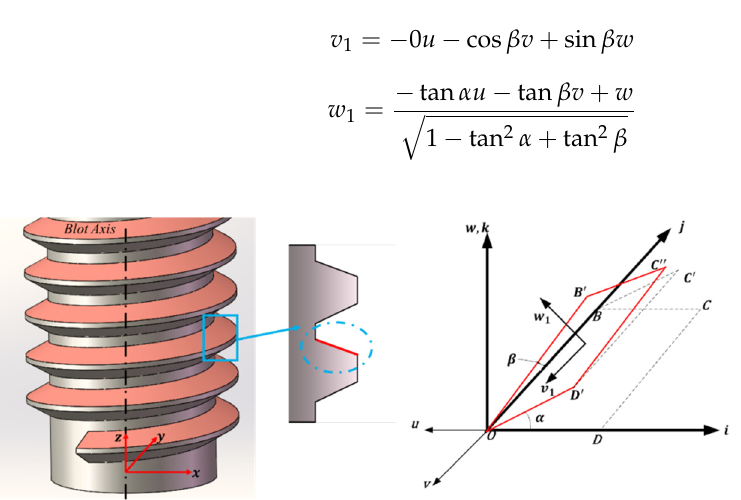
Figure 1. Thread surface coordinate system.